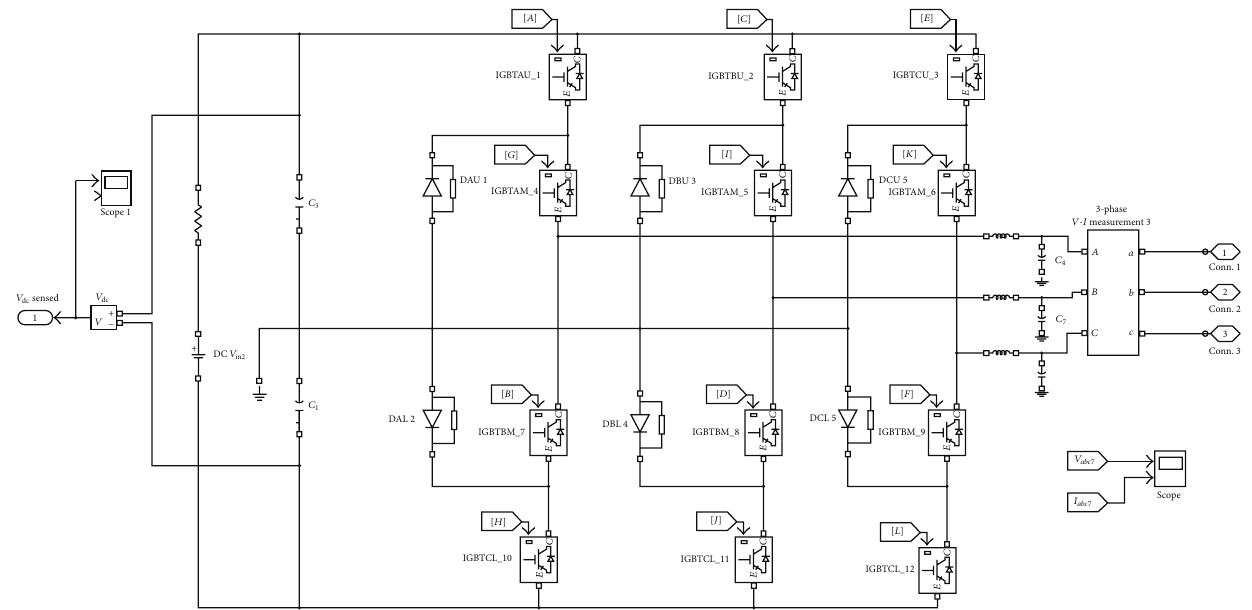
Figure 3: Proposed PIGBT Simulink